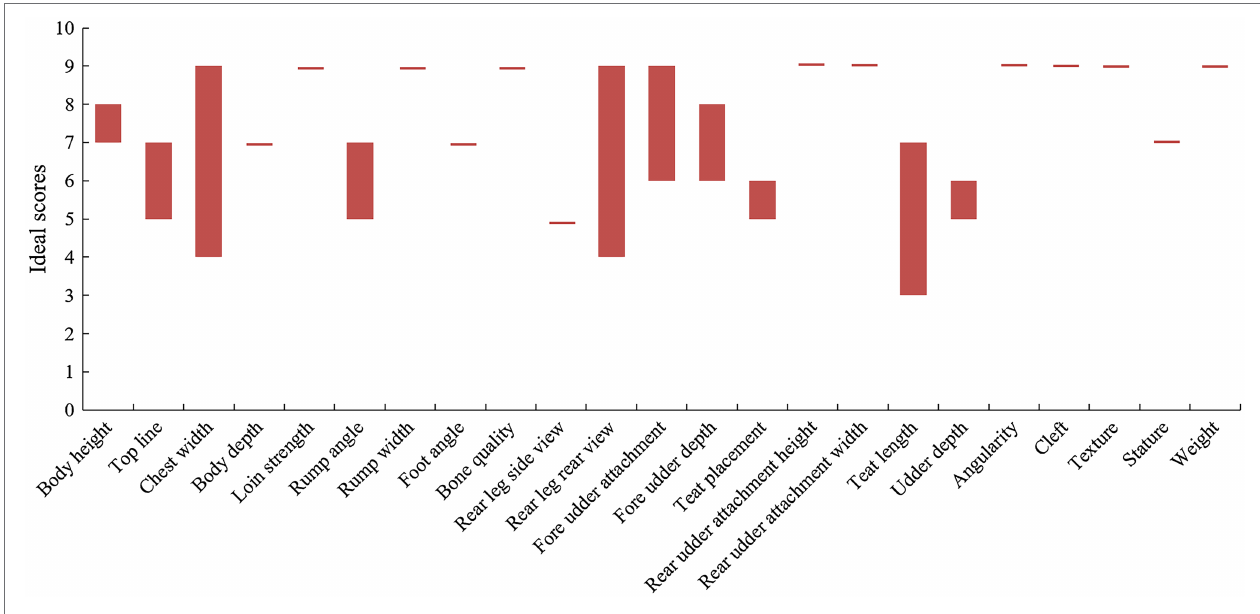
FIGURE 1 | Ideal score for various body traits of dairy cows.